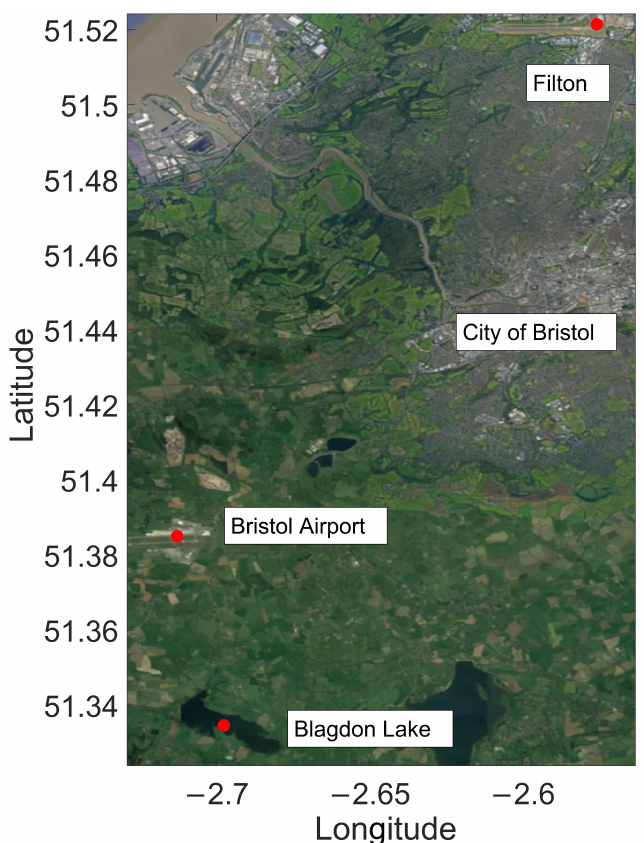
Figure 2. Global position of weather stations (Bristol Airport and Filton) used for the observational weather forcing file. The study site relative to the city and the weather stations is also